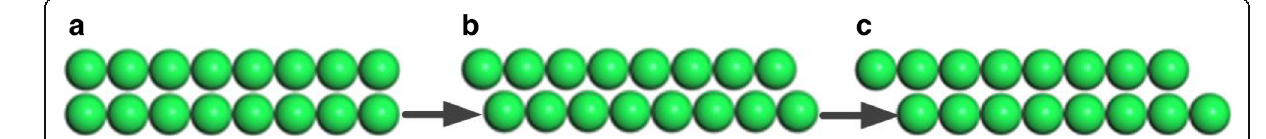
Fig. 12 Schematic view of dislocation changes. Dislocation is a special arrangement of atoms in crystals. It is the crystal in the atomic arrangement along a certain crystal face and crystal orientation occurred in a certain wrong line, and it is the boundary of the slip surface within the area where the slip has occurred and the area with no slip has occurred. In Fig. 12 a – c , the relative displacement of the rigidity of the upper atom and the underlying atom produce dislocations, the upper atom belongs to the sliding region, and the lower atoms belong to the non-slip region, they are in the slip surface of the intersection line which is called dislocation line, that is, dislocation. Figure 12 is the process of dislocation generation and development